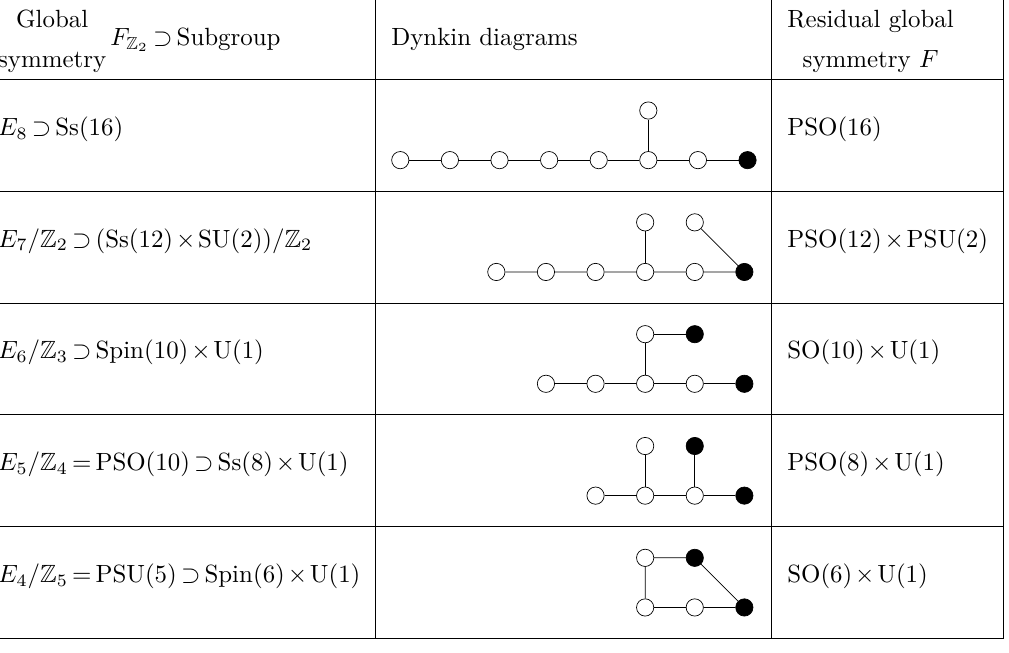
Table 6. Exceptional group F Z = E n / Z 9 − n and its subgroup whose Z 2 quotient is F . The 2 number of U(1) factors is the number of black dots minus 1. Only the cases with connected Dynkin diagrams are presented. Ss is the semispin group, PSO is the projective special orthogonal group and PSU is the projective special unitary group (See table 19 for more details). The Z 2 in row two acts as − 1 simultaneously on the spinors of SU(2) and Ss(12)